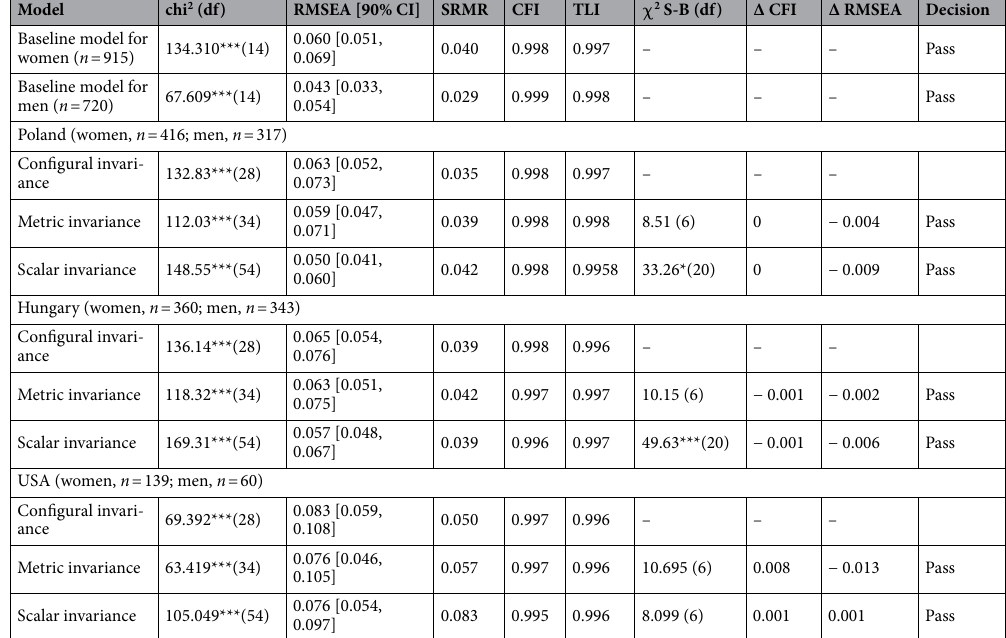
Table 2 for configural model fit statistics). Next, the metric (weak) invariance model, which constrained all factor loadings to invariance, was tested and